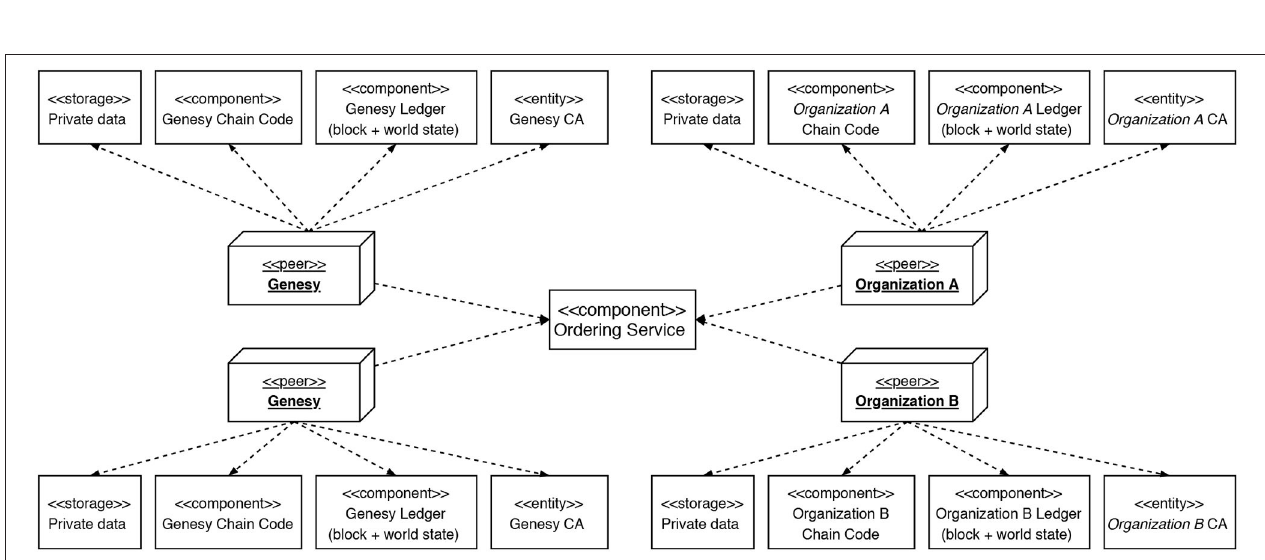
FIGURE 2 | The Peers are nodes of the Blockchain. The Certification Authorities (CAs) are responsible for creating and managing the certificates necessary to guarantee maximum security of the whole system; each CA is entirely dedicated to an Organization, therefore no Organization can generate certificates from a CA other than its own. The Ledgers are where transactions on the Blockchain are indelibly transcribed; any Ledger can be updated only by the Peers with which it is associated and only after the transaction has been validated and approved. The Chaincode supports and implements the Smart Contracts of each Organization. Private Data are kept off-chain. Finally, the Ordering Service receives Signatures from Peers concerning new transactions. Once all Signatures have been collected, it certifies their validity and based on the policies defined in the Network authorizes the transactions and, therefore, generates a new block, whose transactions are transcribed by the Peers on the Ledgers of their